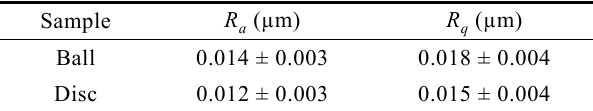
Table 1 Roughness values of the samples for tribological MTM